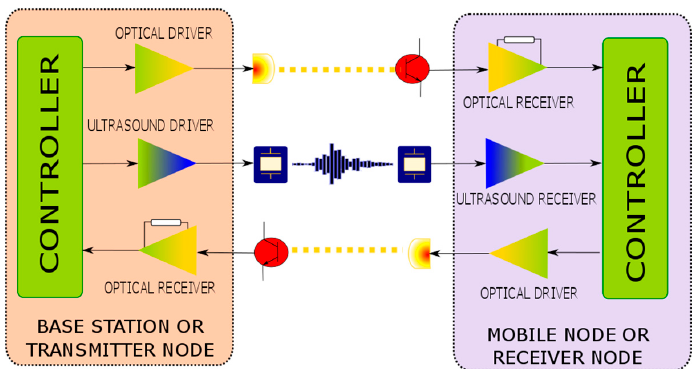
Figure 1. System block diagram.